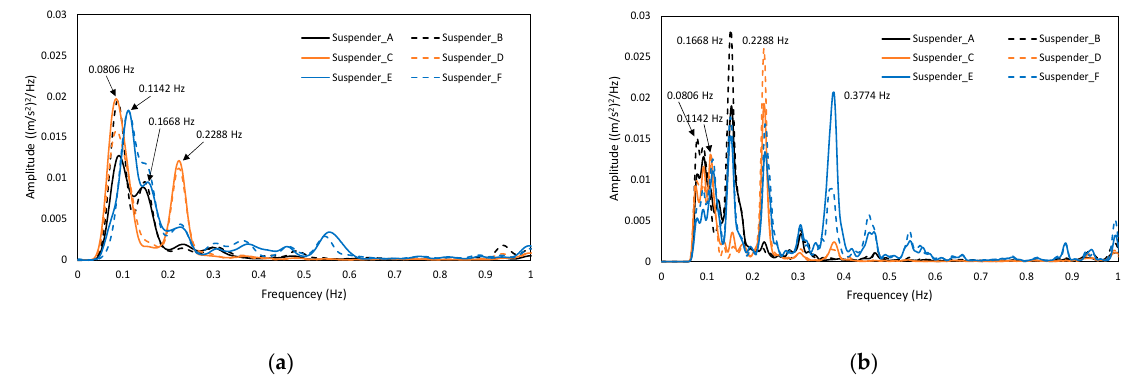
ff erent road roughness. ( a ) Range_A, ( b ) Figure 19. Spectrum analysis results of different road roughness. ( a ) Range_A, ( b ) Range_E. Figure 19. Spectrum analysis results of di